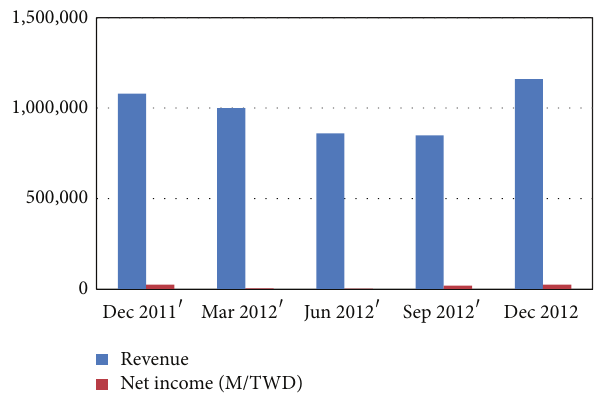
Figure 1: Revenue and net income of Hon Hai Precision Industry Co. Ltd. in period of 2011-2012. (Source: Bloomberg News)